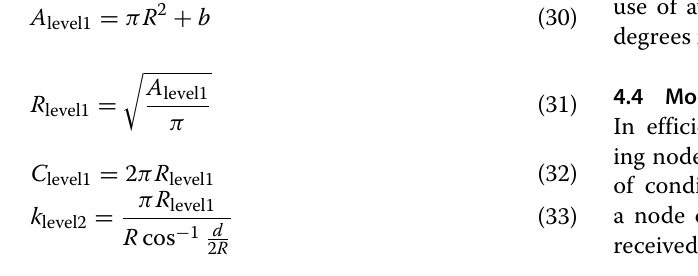
Table 2 Theoretical results for flooding propagation for 20-node sample network Level i Area covered A i ( m 2 ) Rebroadcast radius R i ( m ) No. of arc lengths on cir-